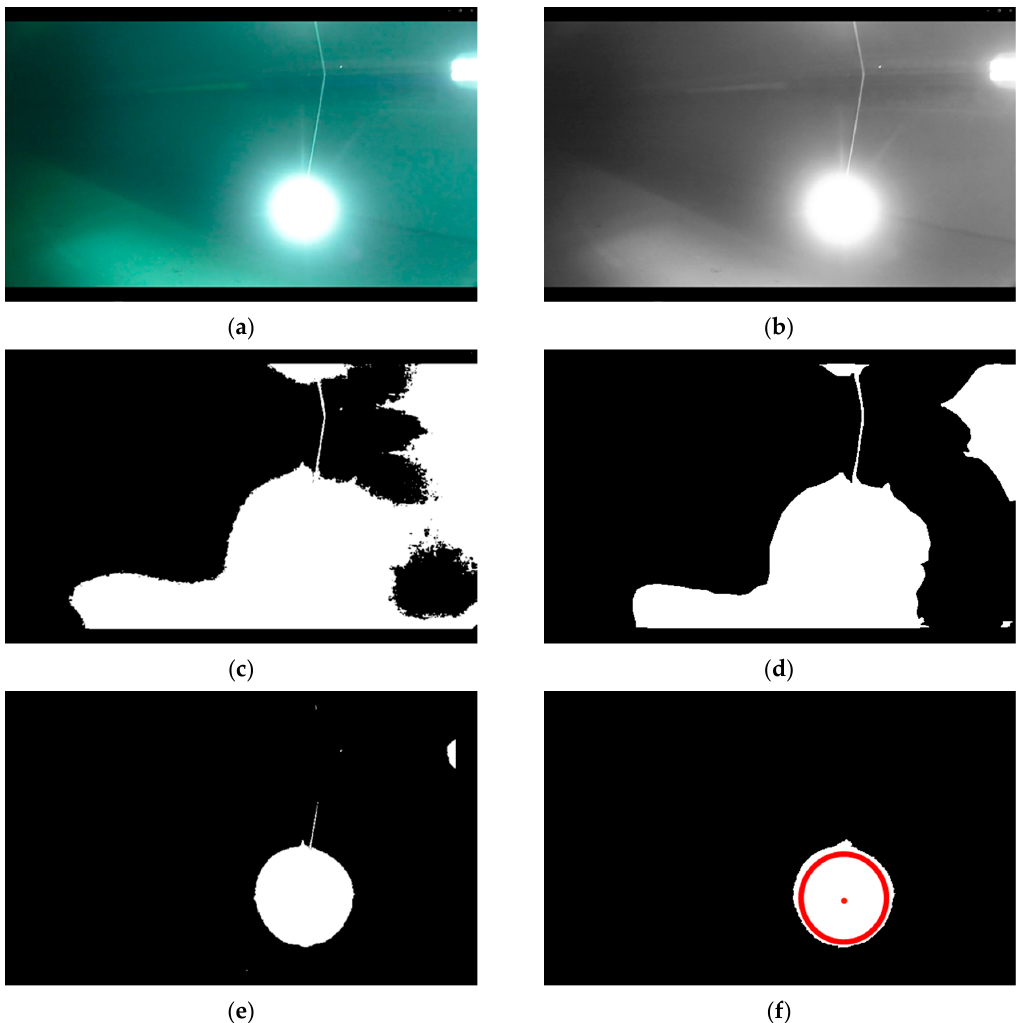
Figure 5. Procedure for ( a ) capturing video from the AUV front camera, ( b ) RGB-to-HSI color space conversion, ( c ) histogram equalization and binarization, ( d ) morphological dilation and erosion, and ( e ) obtaining object profile features, and (f) approximation and circle-fitting algorithms.